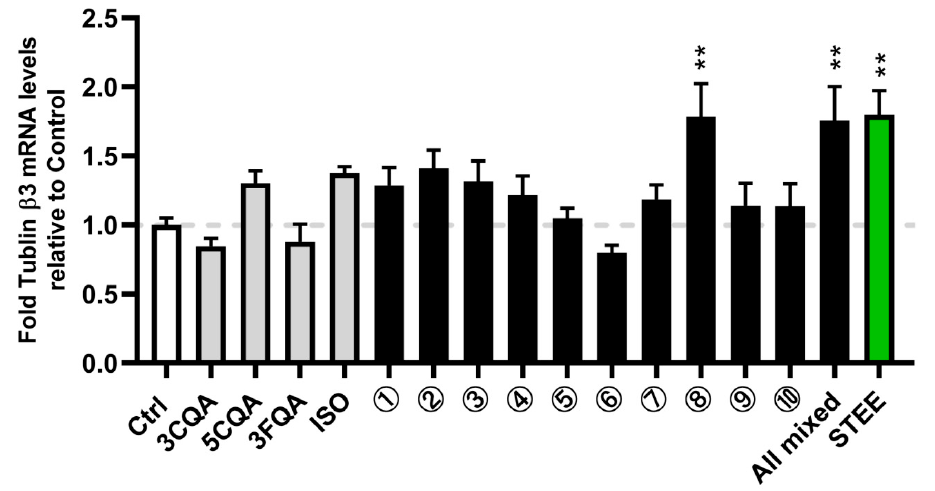
Figure 1. STEE and its major polyphenolic constituents enhanced neuronal marker expression in hNSCs. Cells were treated with STEE and its major polyphenols, 3CQA, 5CQA, 3FQA, or ISO, for 24 h. RNA was isolated from the cells, and tubulin- β 3 mRNA ( TUBB3 ) levels were measured by qRT-PCR. The relative values are the mean ± SEM (n = 3–4) compared with the control. One-way ANOVA with Dunnett’s post hoc test for the comparisons: ** p < 0.01. The description of the number for the treatment groups is indicated in Table